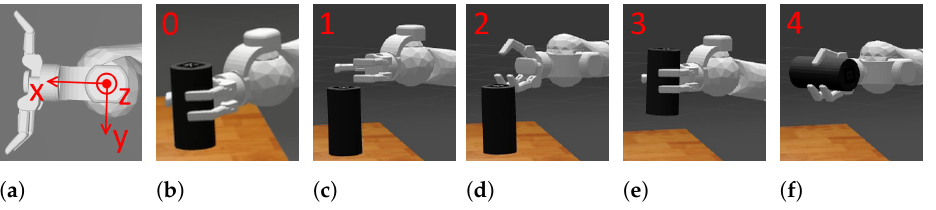
Figure 9. Graphical representation of the identification procedure: ( a ) the local coordinate frame π k , ( b ) checking the grasp configuration of the gripper’s fingers, ( c – f ) the wrench measurements (the numbers in upper left